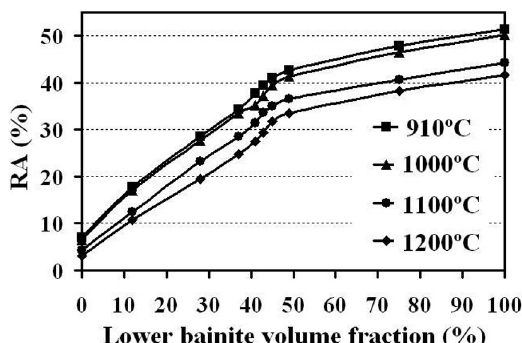
Figure 6. Influence of amount of the lower bainite on elongation of specimens austenitized at different temperatures.